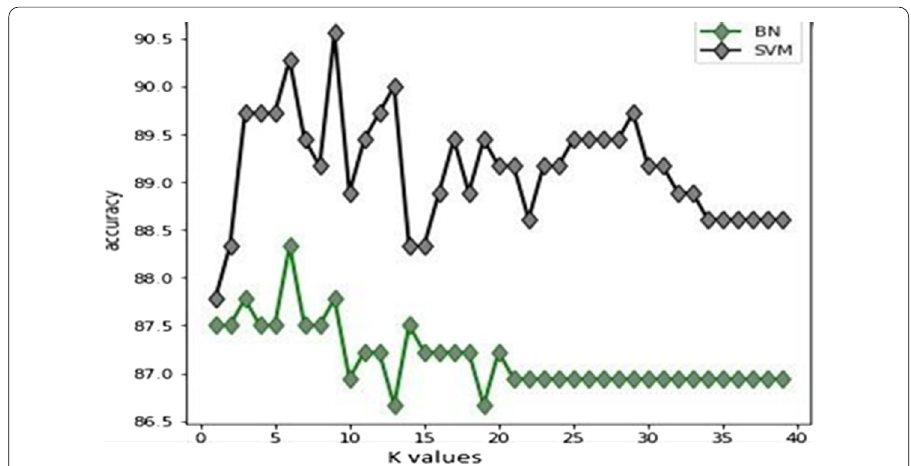
Fig. 2 Variation of k value with